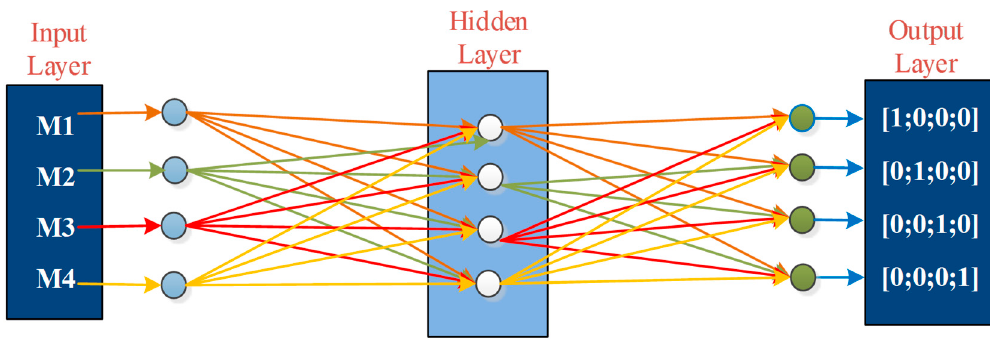
Figure 19. Architecture of proposed artificial neural network-based pose classification.